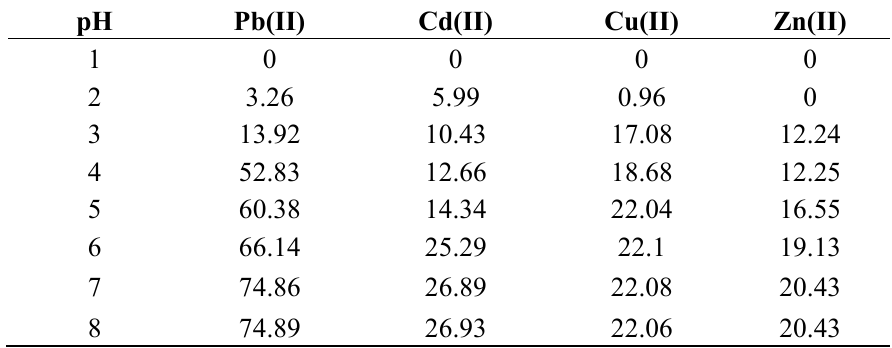
mg/g) according to w,